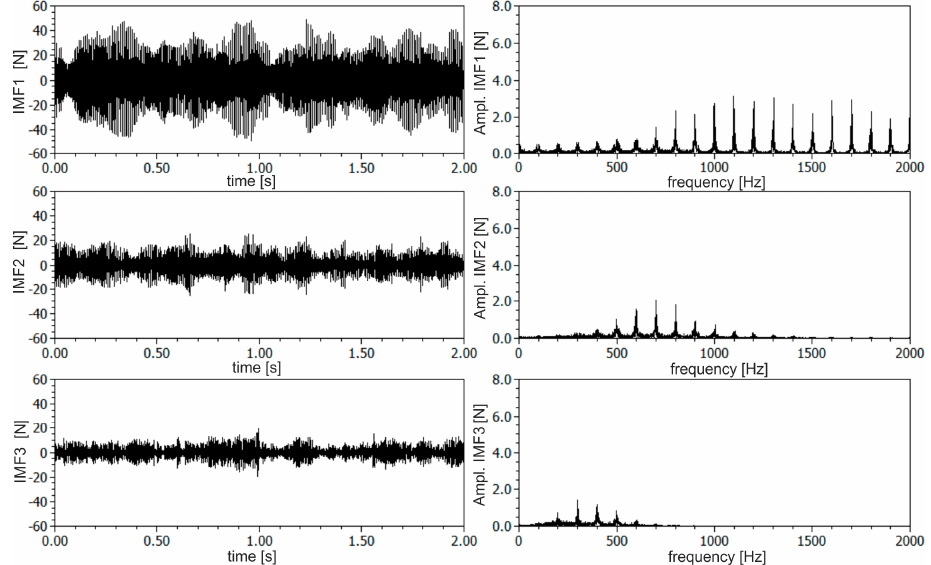
Figure 6. The first three components and their amplitude spectra extracted from the resultant force F xy for stable machining (based on the theoretical SLD), a p = 0.5 mm, n = 6000 rpm.